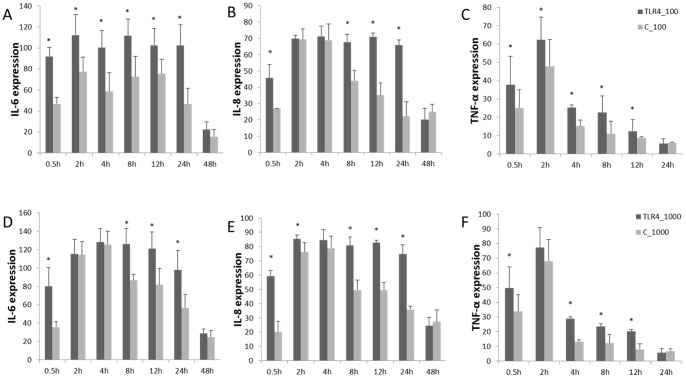
Pro-inflammatory cytokines expression of overexpression TLR4 in fetal sheep fibroblasts under LPS stimulation.A), B), and C) show the expression of IL-6, IL-8, and TNF-α under LPS (100 ng/mL) stimulation. D), E), and F) show expression of IL-6, IL-8, and TNF-α under LPS (1000 ng/mL) stimulation. In graph: C =  subjects transfected with p3S-LoxP transfected fetal fibroblasts, subjects transfected with TLR4 = pTLR4-3S fetal fibroblasts. Data are means ± SE. * Values within the same concentration of LPS differ significantly across different groups (P<0.05).